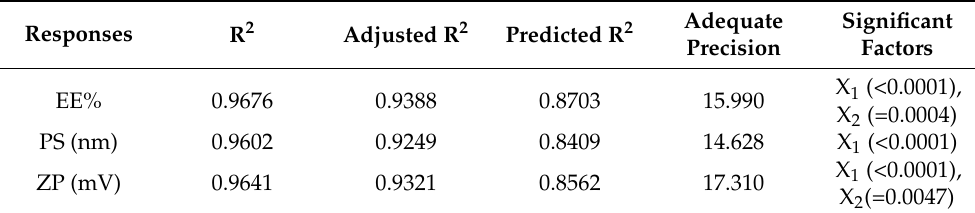
Table 4. Output data of the full factorial analysis of TOL basic